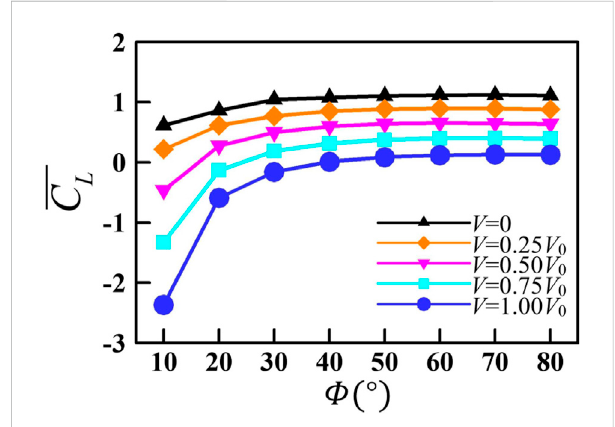
FIGURE 10 Variation in the mean lift coef fi cient C L as a function of the fl apping amplitude Φ of the wing at different up- fl ight speeds V